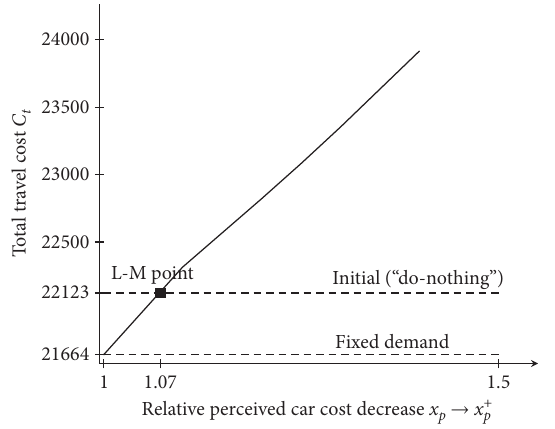
Figure 11: Travel costs C in the mode-choice model U